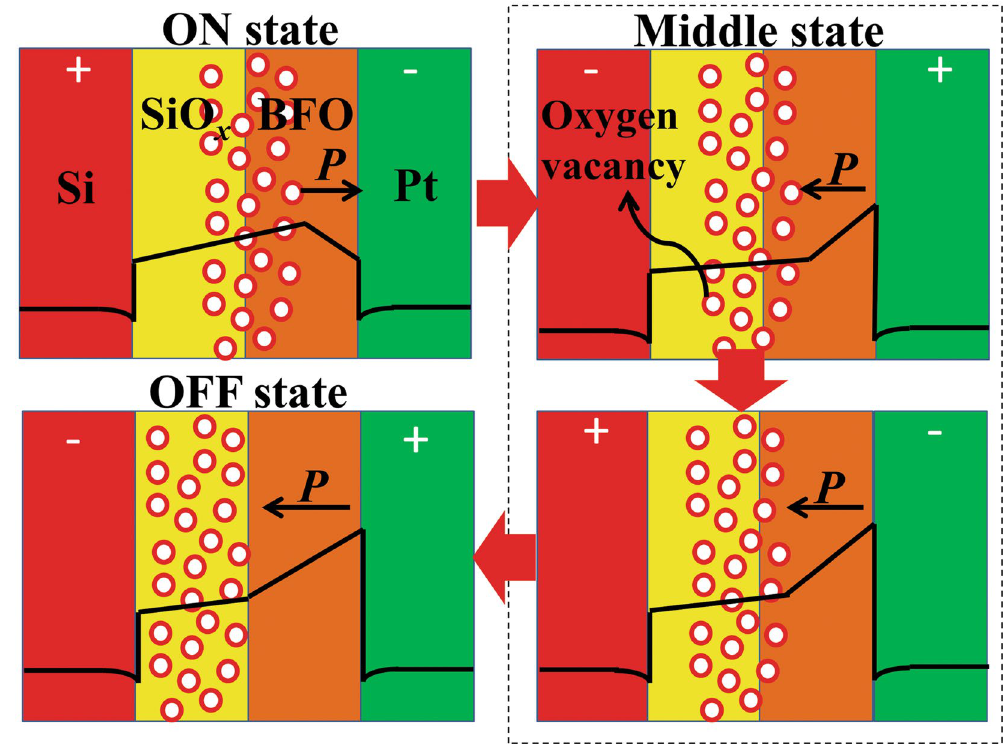
Figure 6. A possible mechanism of ON/OFF state in the device with 3.5 nm thick BFO